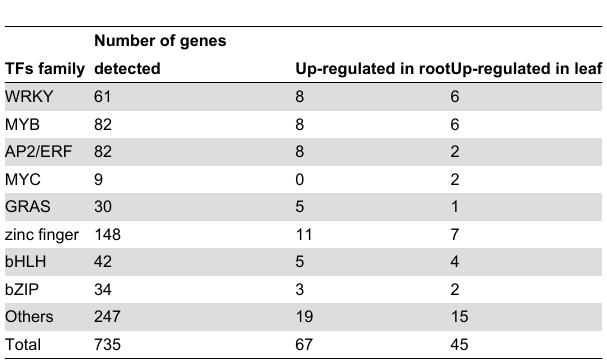
Table 5. Summary of transcription factor unigenes of S. miltiorrhiza